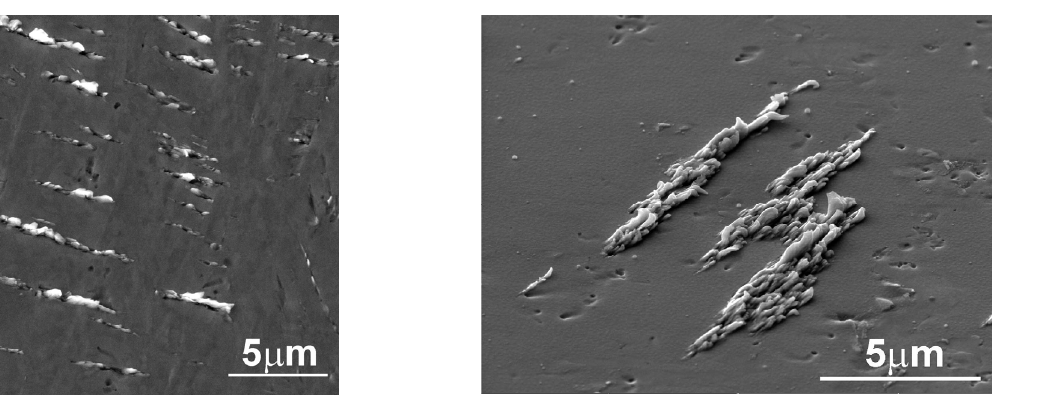
Figure 11: Cyclic slip band on the surface of UFG Cu loaded in gigacycle